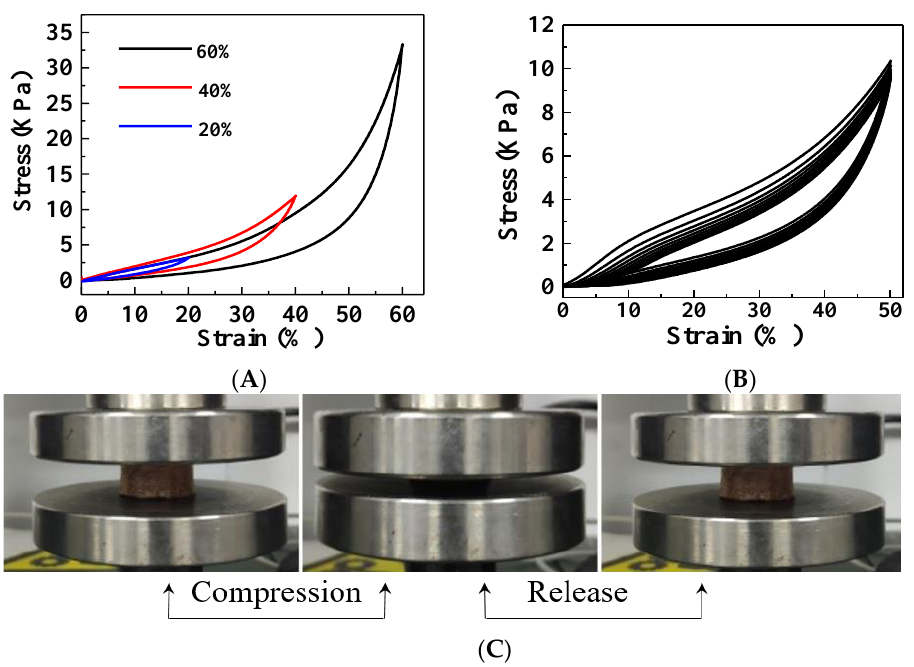
Figure 4. Compression stress-strain curves under 20%, 40%, and 60% strains ( A ), cyclic stress-strain curves at 50% strain for 10 cycles ( B ), and the pictures of the tenth cycle compress and release process at 50% strain of F-CS aerogel ( C ).